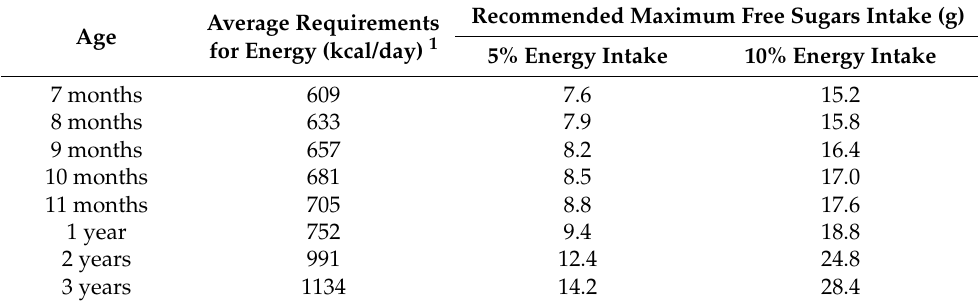
Table reproduced from [6]; 1 average values estimated for males and